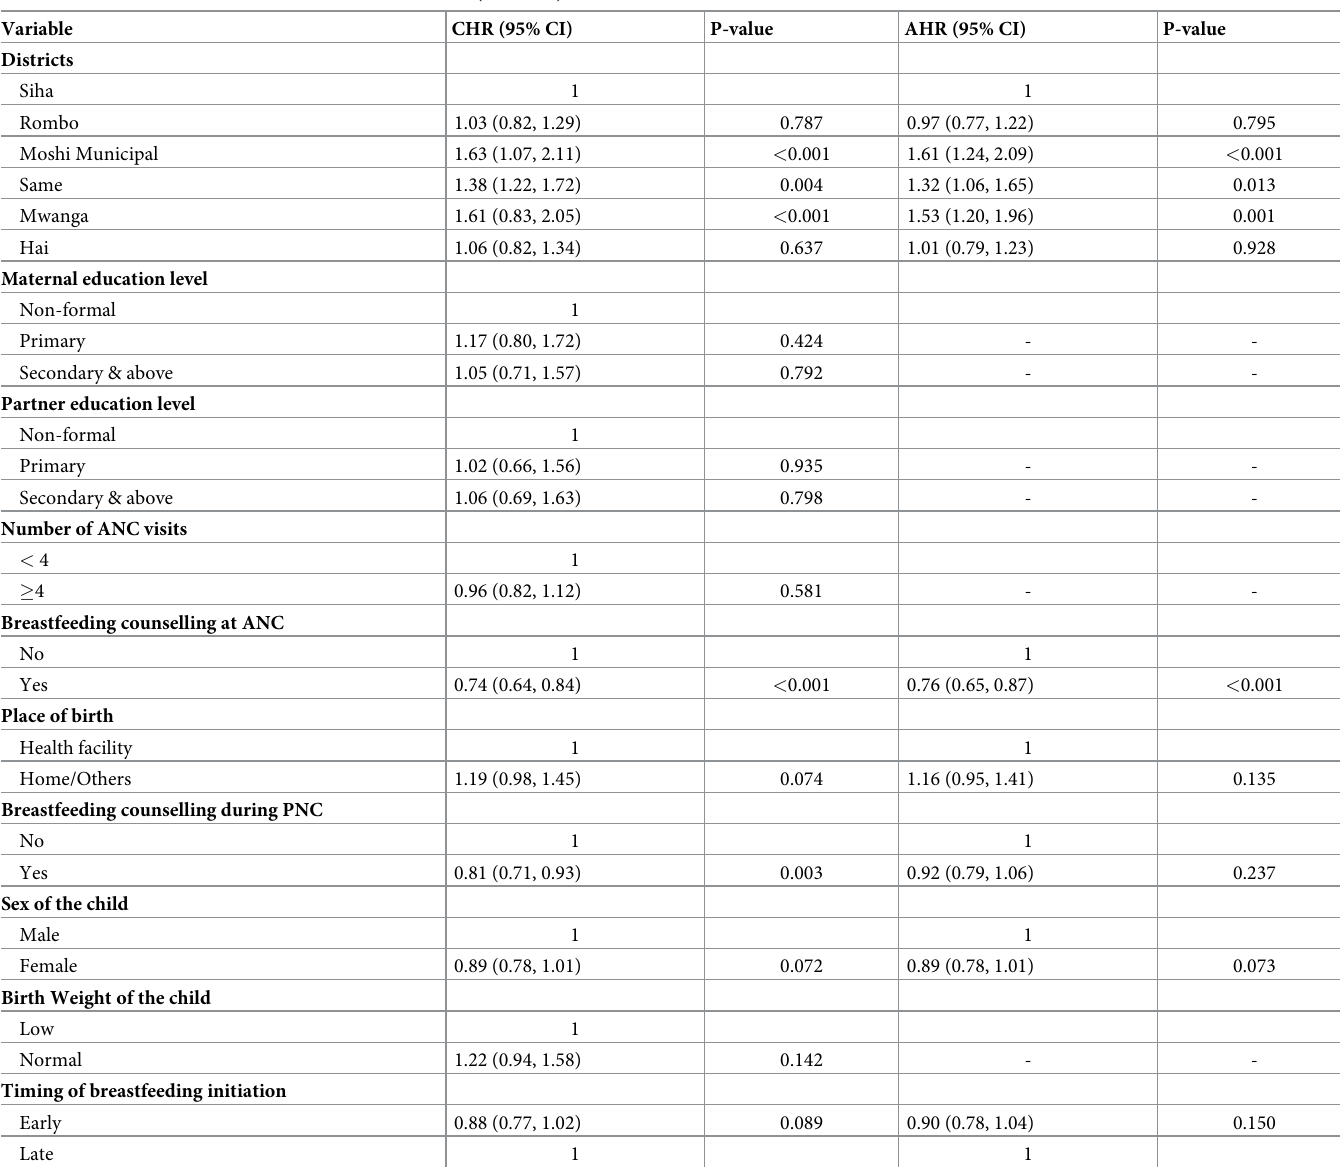
Table 5. Factors associated with time to cessation of EBF (N =